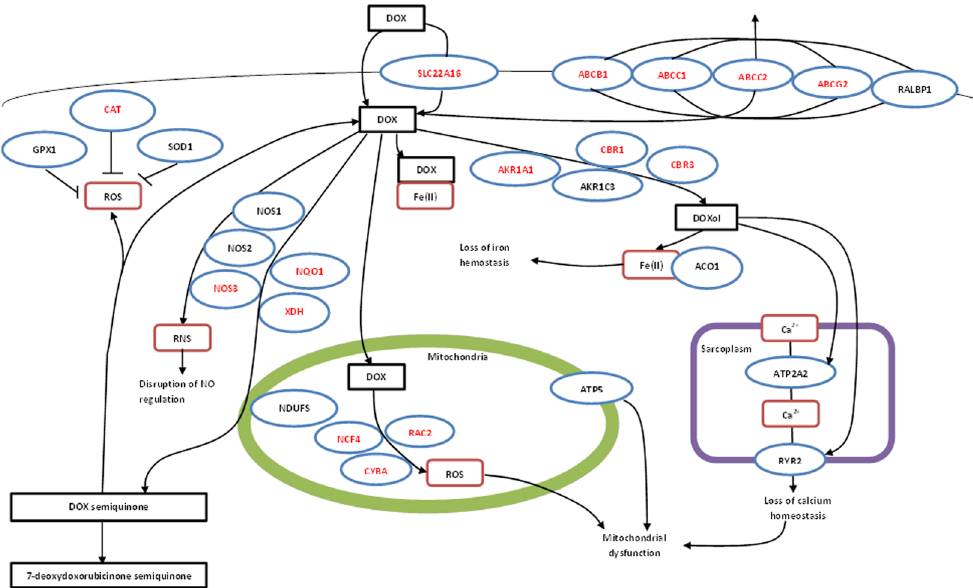
Figure 4. Diagrammatic representative of the candidate genes involved in transport and metabolism of doxorubicin and doxorubicin induced cardiotoxicity. ABCB1, ATP-Binding Cassette Subfamily B Member 1; ABCC1, ATP-Binding Cassette Subfamily C Member 1; ABCC2, ATP-Binding Cassette Subfamily C Member 2; ABCG2, ATP-Binding Cassette Subfamily G Member 2, ACO1, Aconitase 1; AKR1A1, Aldo-Keto Reductase Family 1 Member A1, AKR1C3, Aldo-Keto Reductase Family 1 Member C3; ATP2A2, ATPase Sarcoplasmic/ Endoplasmic Reticulum Ca 2 + Transporting 2; ATP5E, ATP synthase H + Transporting, mitochondrial F1 Complex, Epsilum Subunit; CAT, Catalase gene; CBR1, Carbonyl Reductase 1; CBR3, Carbonyl Reductase 3; CYBA, Cytochrome B-245 Alpha Chain; GPX1, Glutathione Peroxidase 1; NCF4, Neutrophil Cytosolic Factor 4; NDUFS, NADH: Ubiquinone Oxidoreductase Subunit; NOS1, Nitric Oxide Synthase 1; NOS2, Nitric Oxide Synthase 2; NOS3, Nitric Oxide Synthase 3; NQO1, NAD(P)H Quinone Dehydrogenase 1; RAC2, Ras-related C3 Botulinum Toxin Substrate 2; RALBP1, RalA Binding Protein 1; RYR2, Ryanodine Receptor 2; SLC22A16, Solute Carrier Family 22 Member 16; SOD1, Superoxide Dismutase 2, mitochondrial; XDH, Xanthine